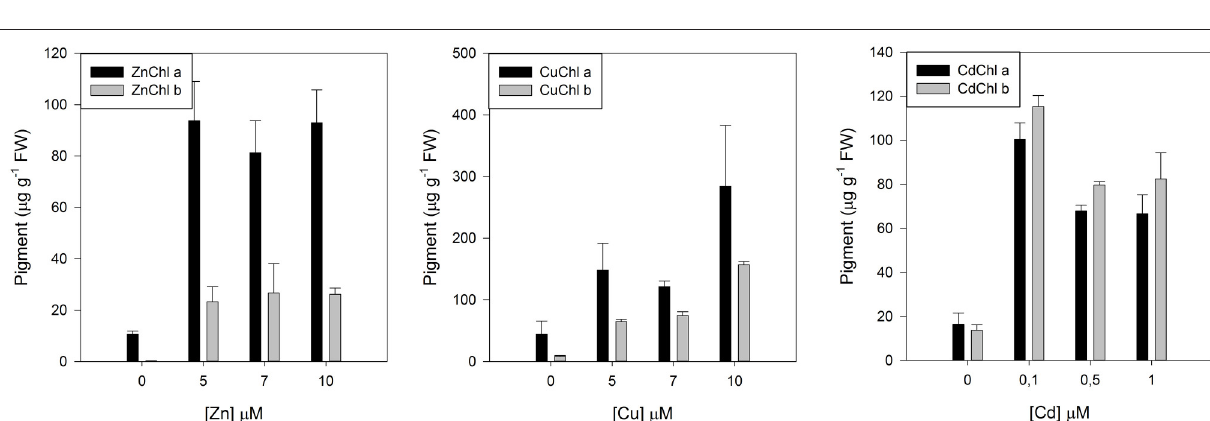
FIGURE 6 | Contribution of the light reactions (TR 0 /DI 0 ) and dark reactions ( ψ o /(1 – ψ o )) and correspondent redox reactions between PS II and PSI equilibrium constant ( ψ Eo /(1 − ψ Eo )), in Juncus accutus exposed to increased doses of cadmium (Cd). Data is presented as average ± standard deviation. The concept of this figure is based on Santos et al. (2014).